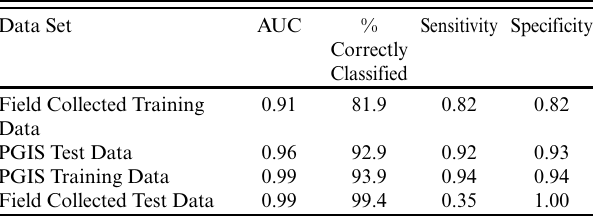
Table 2 . Maxent statistical accuracy measurements with the final model produced using field collected training data and participatory mapping (PGIS) test data, and switched data sets using participatory mapping training data and field collected test data.